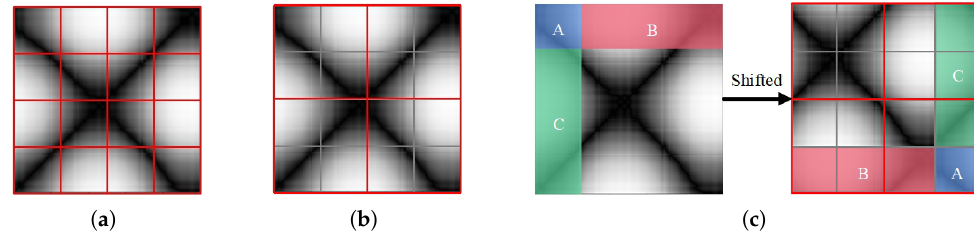
Figure 7. MSA, W-MSA, and SW-MSA calculation window selection difference display. ( a )